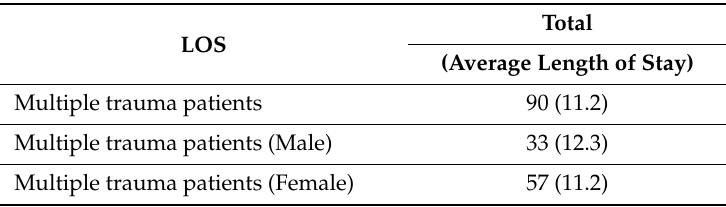
Table 10. Average length of stay of multiple trauma